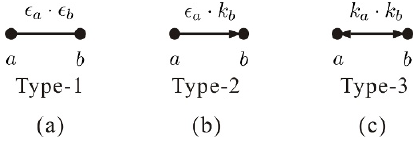
Figure 2 . Two types of starting points of chains.